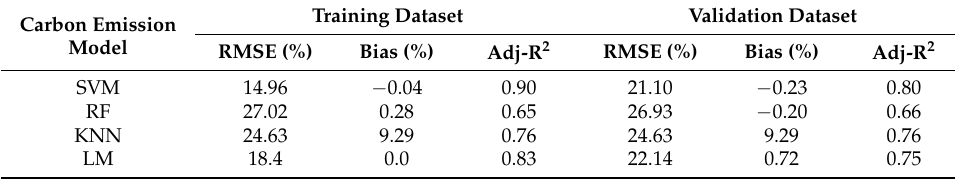
Figure 7. Plots of carbon emission models; RF ( A ), KNN ( B ), SVM ( C ), and LM ( D ). Table 5. Training and validation results of the carbon emission model.